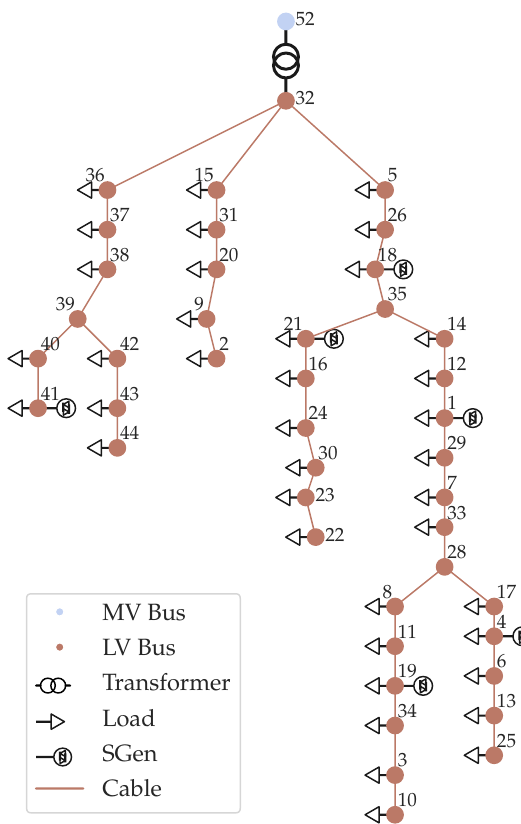
Figure 7. “1-LV-semiurb4--2-no_sw”.